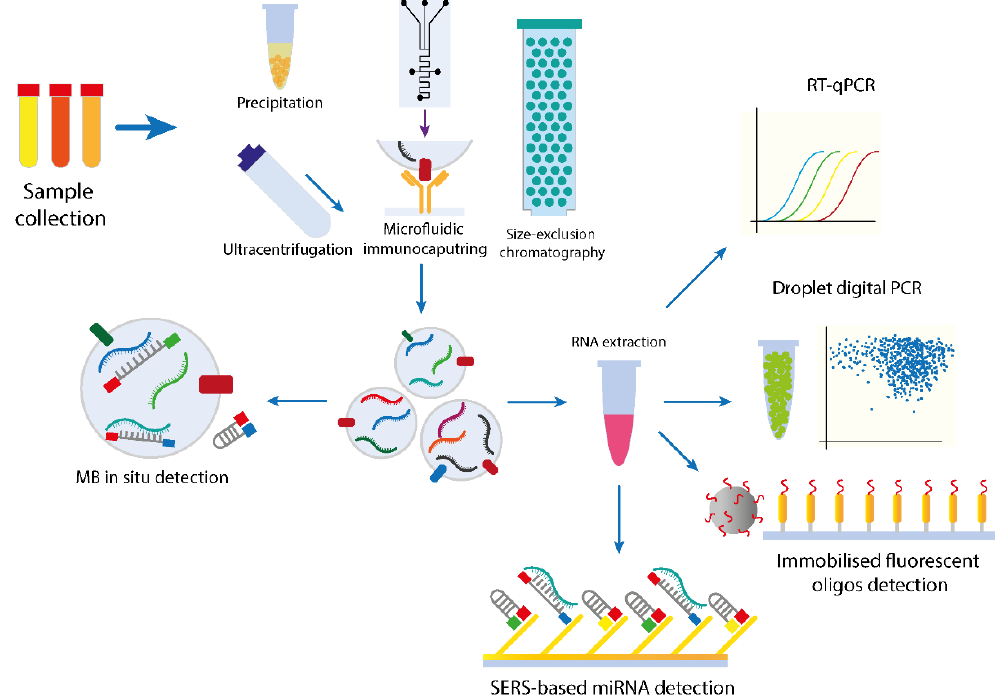
Figure 2. Overview of the described methods for characterization and quantification of exosomal miRNA. The workflow of exosomal miRNA detection and characterization varies based on the methods used for isolation, the efficiency, and yields of which have been previously described. Following this, most methods rely on the prerequisite RNA isolation from the exosomes to be analyzed using either amplification-based assays (RT-PCR or ddPCR) or oligo-based fluorescent or Surface-Enhanced Raman Scattering (SERS)-based techniques that can offer a more direct quantification. In situ detection methods can overcome the biological limitation imposed by the exosome lipid membrane and can detect the target miRNA inside the exosomes.